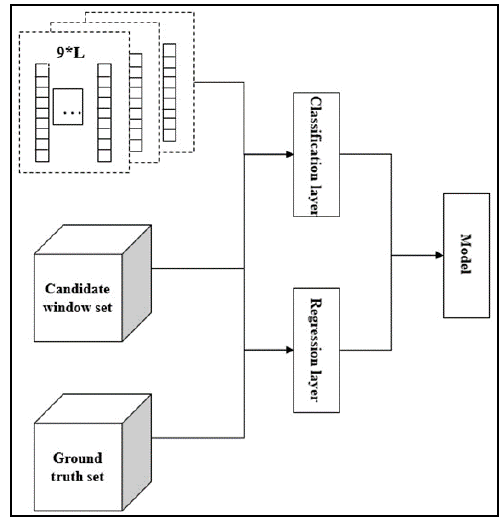
Figure 5. Detection model process. The inputs are label, candidate window set and fixed dimension map of candidate window. The output is the detection model. The classification layer and regression layer have the same role as RPN.